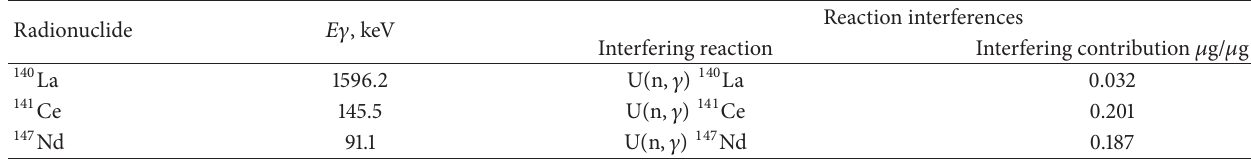
Table 3: Interferences due to energy and reactions.